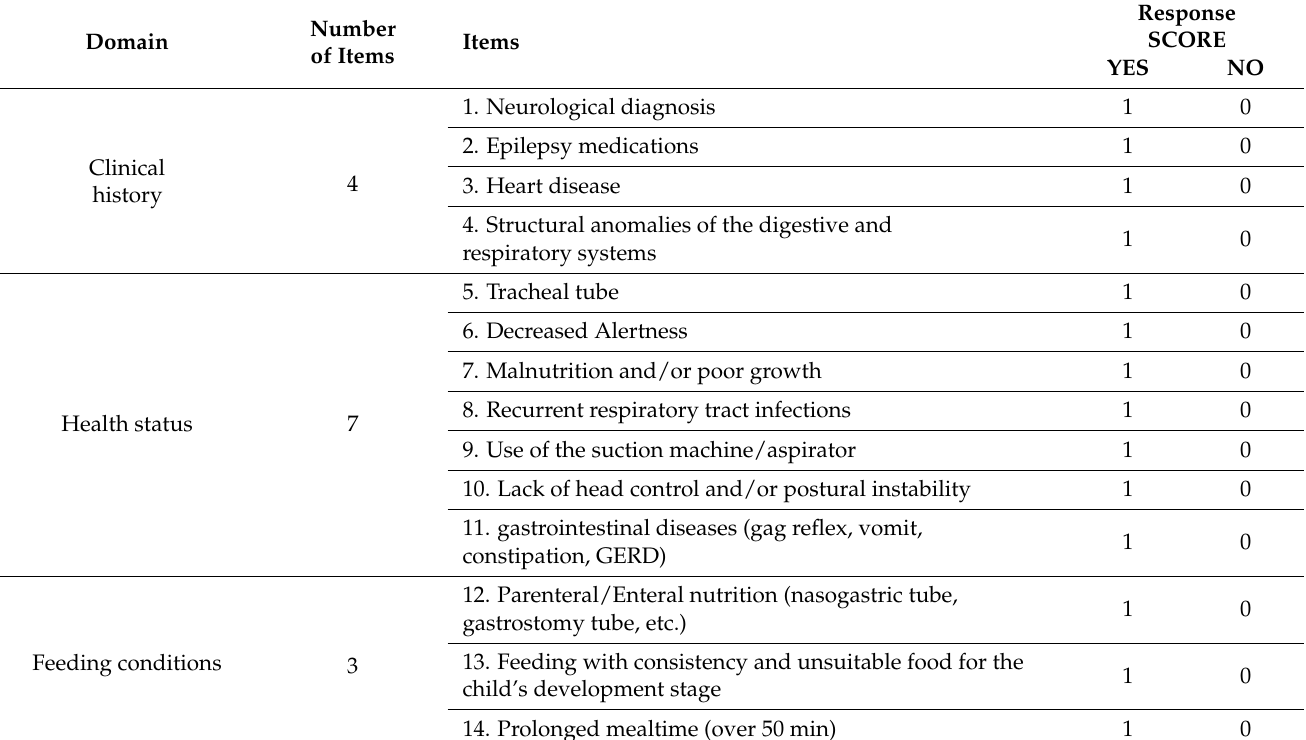
Table 2. Final English version of the Priority Evaluation Dysphagia